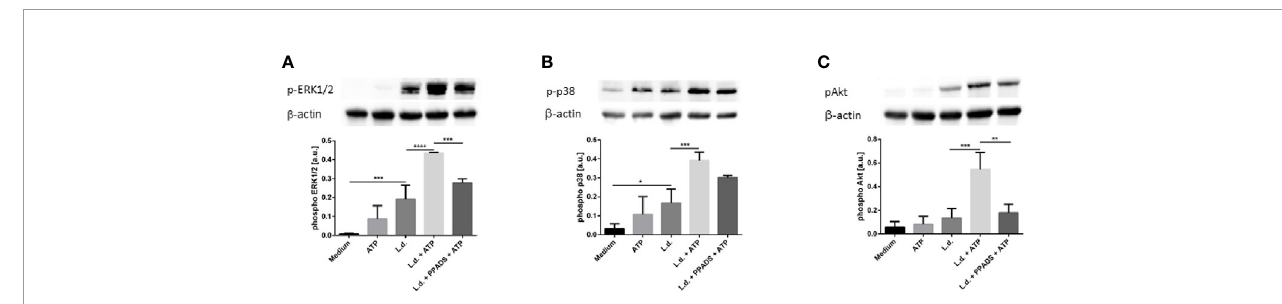
FIGURE 7 | The effect of extracellular ATP and UTP on the phosphorylation of p38, Akt and ERK1/2 in neutrophils. Neutrophils were exposed to ATP (500 µM), UTP (500 µM), Leishmania donovani promastigotes ( Leishmania to neutrophil ratio 10:1) or a combination of ATP or UTP with Leishmania donovani promastigotes for 15 min at 37°C. In samples with the P2-antagonist PPADS the neutrophils were pretreated with the inhibitor (30 µM) for 15 min. Whole cell lysates were prepared and phosphorylation of ERK1/2 (A) , p38 (B) and Akt (C) were analyzed by Western Blot. Representative blots are shown in the upper parts of the panels. Phosphorylation of ERK1/2, p38 and Akt was quanti fi ed by densitometry analysis. Signals of pAkt, pERK1/2, or pp38 were related to b -actin signals on the same blots. n=4, *p ≤ 0,05, **p ≤ 0,01, ***p ≤ 0,001, ****p ≤